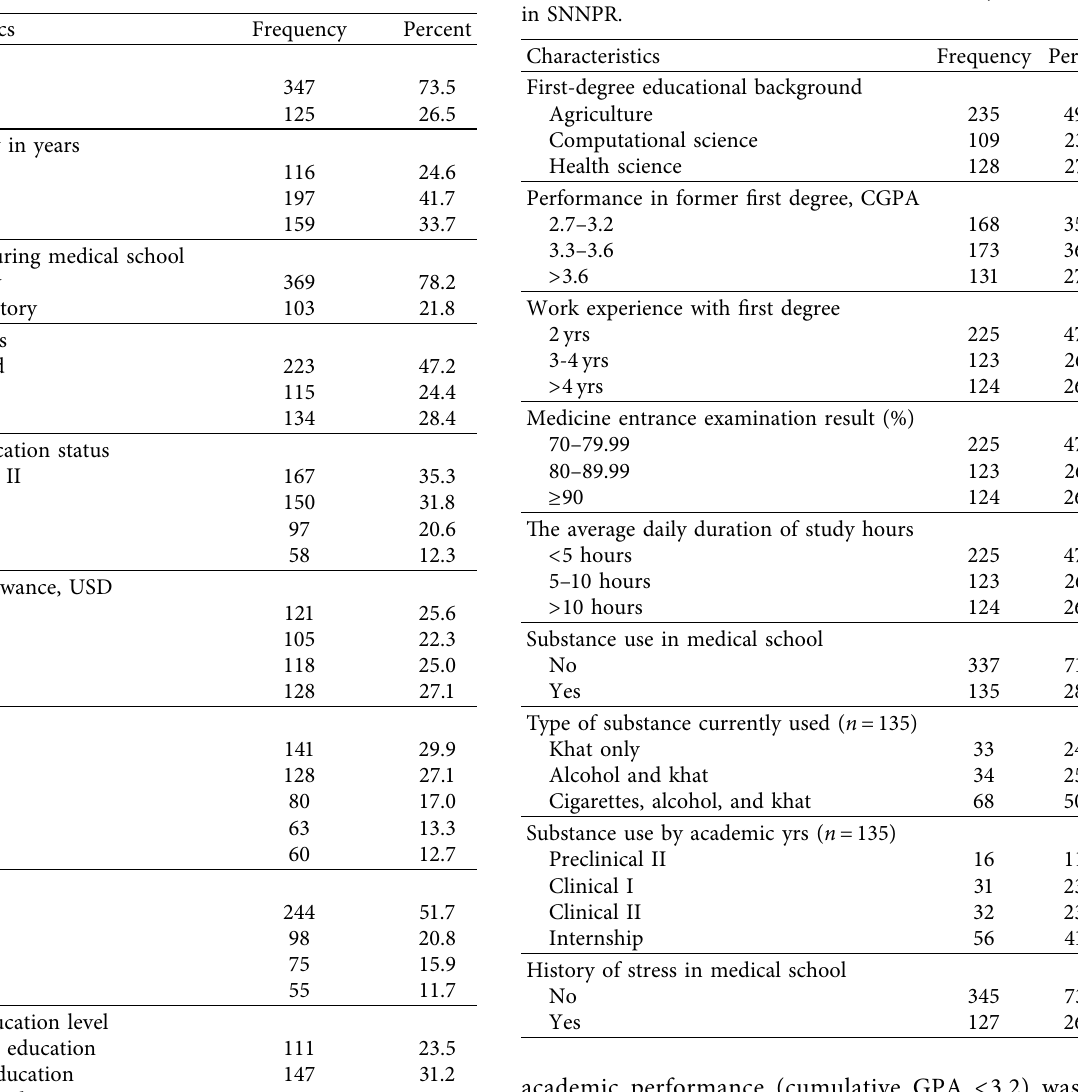
Table 1: Sociodemographic characteristics of new medical edu- cation system students in SNNPR.